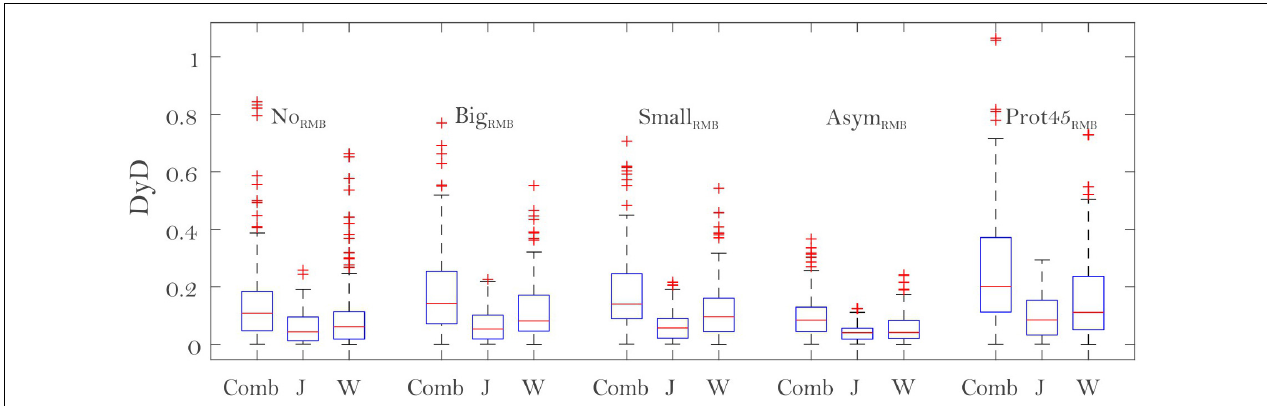
FIGURE 14 | Box plots with average DyD using all numerical simulations for the five RMB configurations. Comb is Combined DyD ; J is DyDJ ; W is DyDW